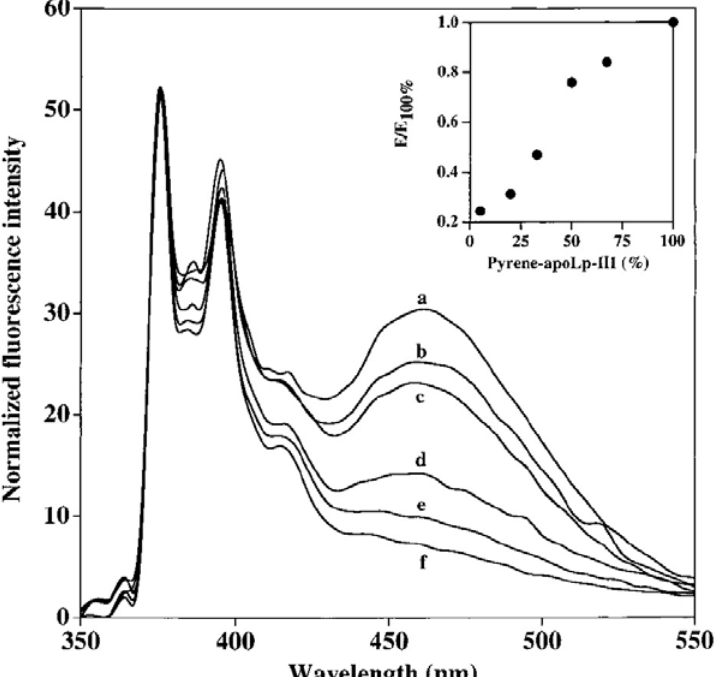
Figure 6. Fluorescence emission spectra of lipid-bound pyrene-N40C/L90C-apoLp-III. The spectra of lipid-bound protein with pyrene-N40C/L90C-apoLpIII only (curve